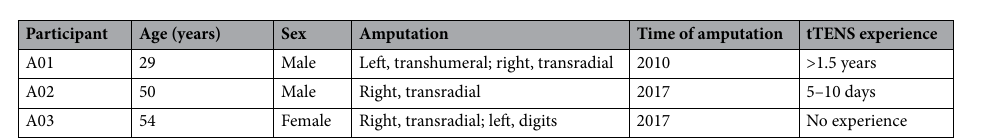
Figure 2. Experimental paradigm. ( A ) During the EEG experiment, the participant wore a 64-channel EEG cap and sat in front of a computer screen on which a visual cue of a hand movement was shown. The participant attempted the hand movement with or without tTENS. ( B ) The experiment consisted of four conditions: Pre- Stim, Stim-Only, Stim-Move, and Post-Stim. ( C )–( E ) Each participant with upper limb amputations selected different hand movements and stimulation regions. ( C ) Participant A01 associated median sensation with tripod, ulnar sensation with point, and wrist sensation with wrist flexion. ( D ) A02 associated median sensation with hand open, and wrist sensation with hand close. ( E ) A03 associated sensation on the back of the hand with hand open.